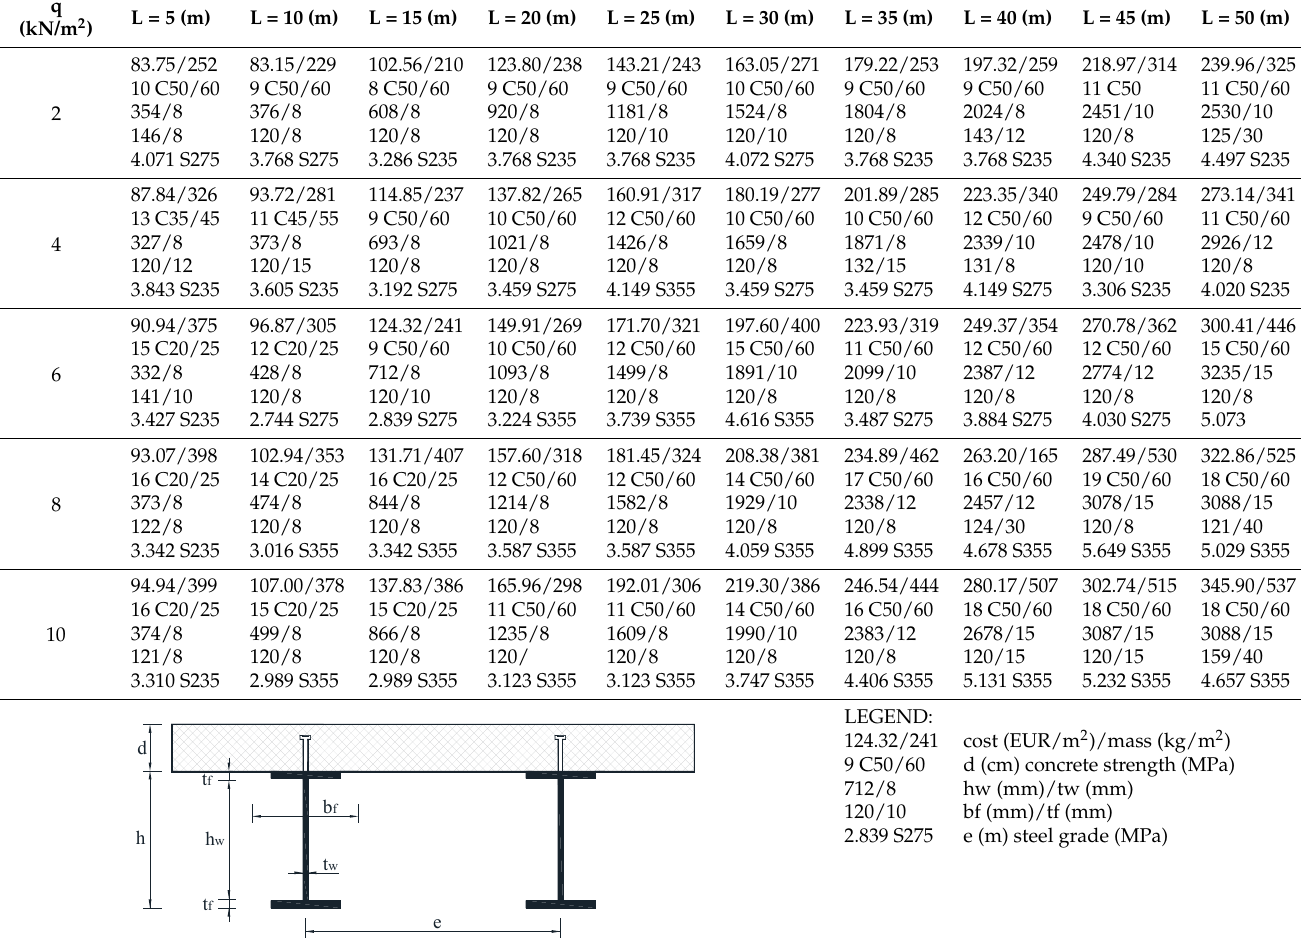
Table 5. Recommended optimal design for the CFSWIS system (ELCC EEC).